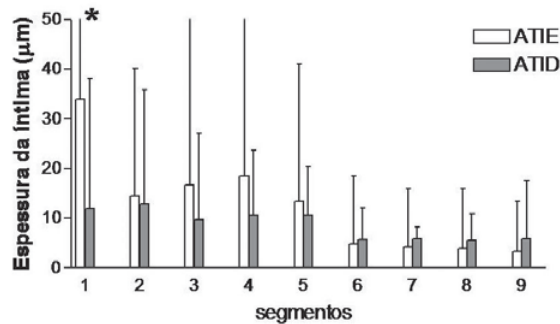
Fig. 5 - A comparação da espessura da camada íntima mostrou não existir diferença estatisticamente significativa entre a artéria torácica interna esquerda (ATIE) e direita (ATID), com exceção do segmento 1, com o valor do segmento da ATID sendo menor que a ATIE (* diferença significativa entre ATIE e ATID,